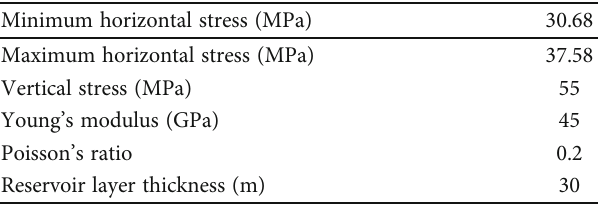
Table 1: Basic parameters of the target formation.